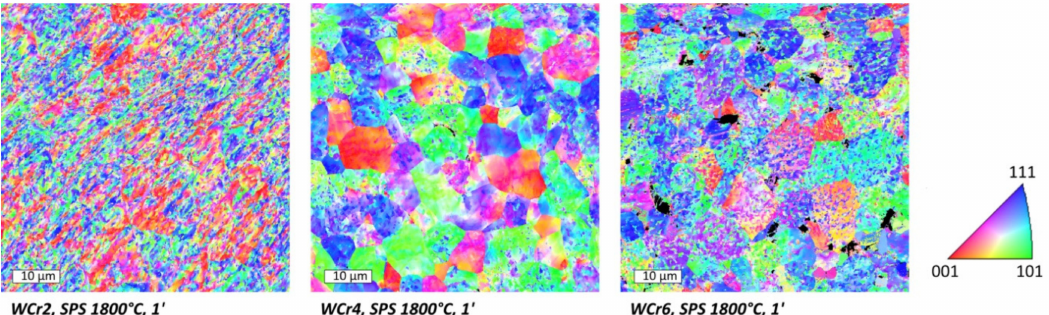
Figure 7. Electron backscattered diffraction (EBSD) images representing the grain orientations on 60 × 60 µ m 2 areas.